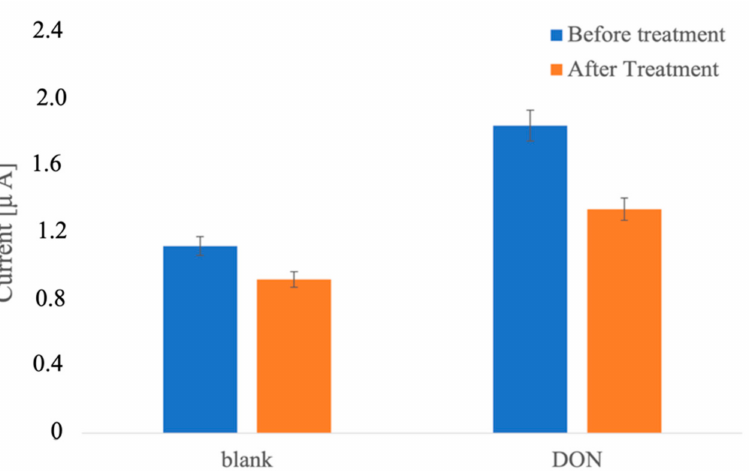
Figure 7. DPV responses (peak heights) before and after treatment in the detachment solution (methanol, acetonitrile, and water 10:10:80). Number of electrodes tested = 5.